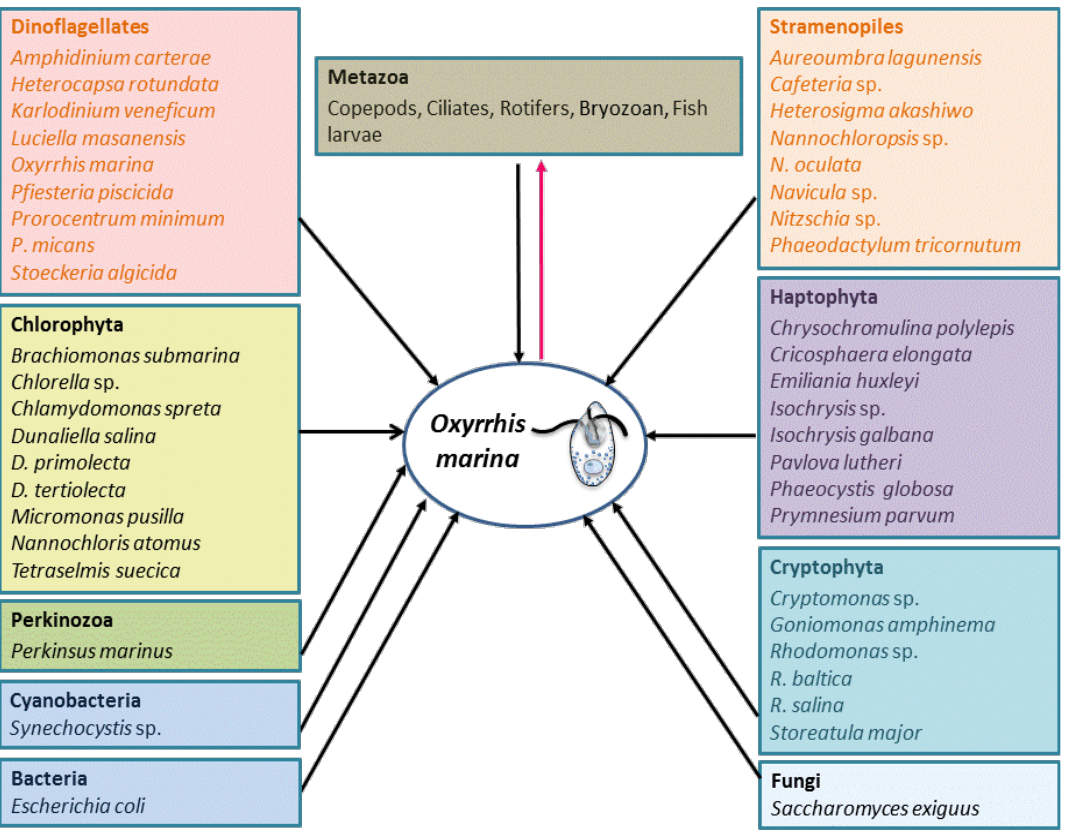
Figure 1. The schematic showing relationships of O . marina with other organisms as prey and predators as documented in literature. The black-colored arrows emerging from the variety of prey all point to O . marina as the grazer, while the red-colored arrow emerging from O . marina leads to the diverse predators of O . marina